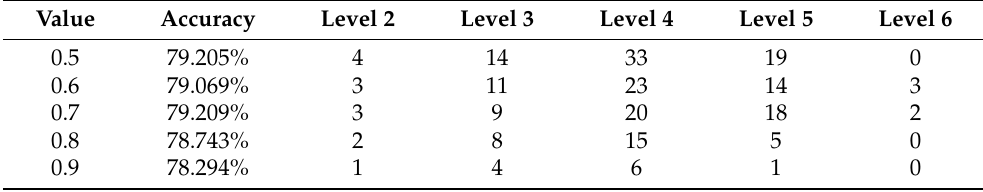
Table 3. TESSOM accuracy with entropy variation.